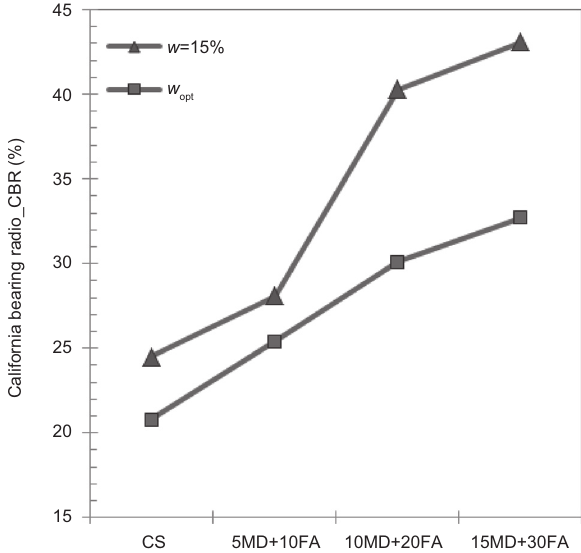
Figure 3 CBR values of